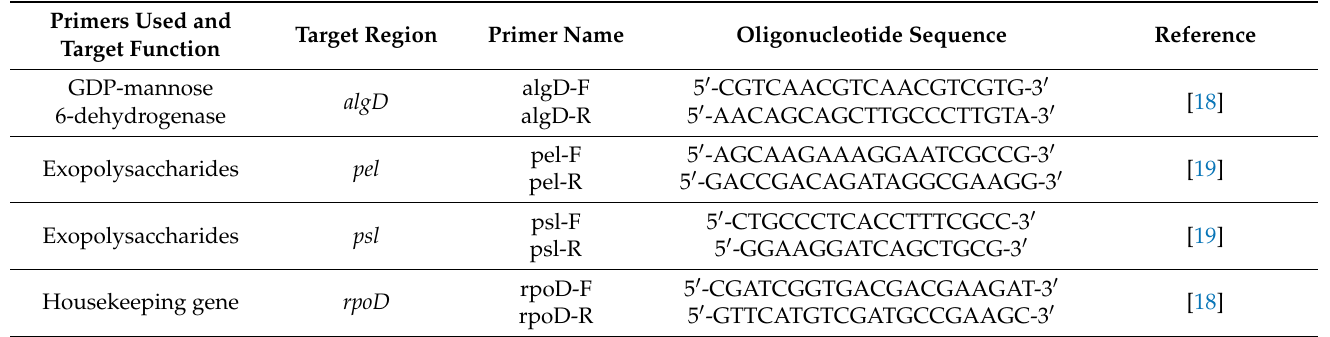
Figure 1. Schematization of the BioFlux TM 200 organization. This system delivers controlled shear flow for simulating physiological and environmental conditions. It allows the connection by microchannel of an inflow well to an outflow well. Biofilm formation will occur in the microfluidic channel under shear flow condition. A microscope can be placed underneath the microfluidic channel, allowing a live observation of the biofilm formation. Table 2. Primers used in the